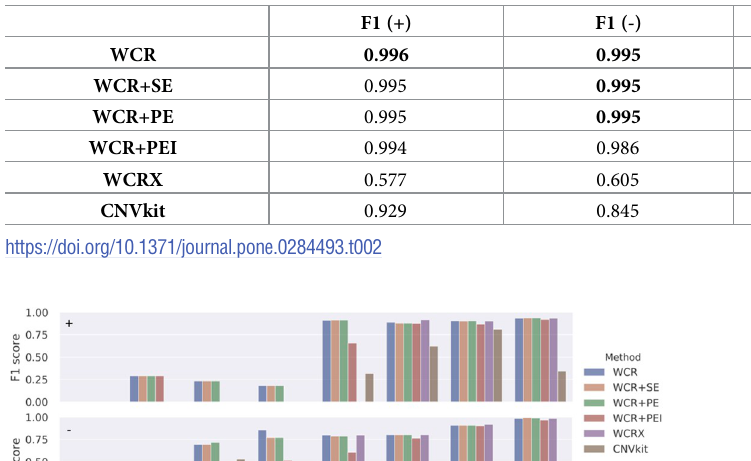
Table 2. Averaged F1 performance in simulated data. F1 score as averaged across all event sizes (1 to 78 Mb) for simulated duplications (+), deletions (-), and the number of false positive calls (FP) of the different methods using a 250 kb bin size.